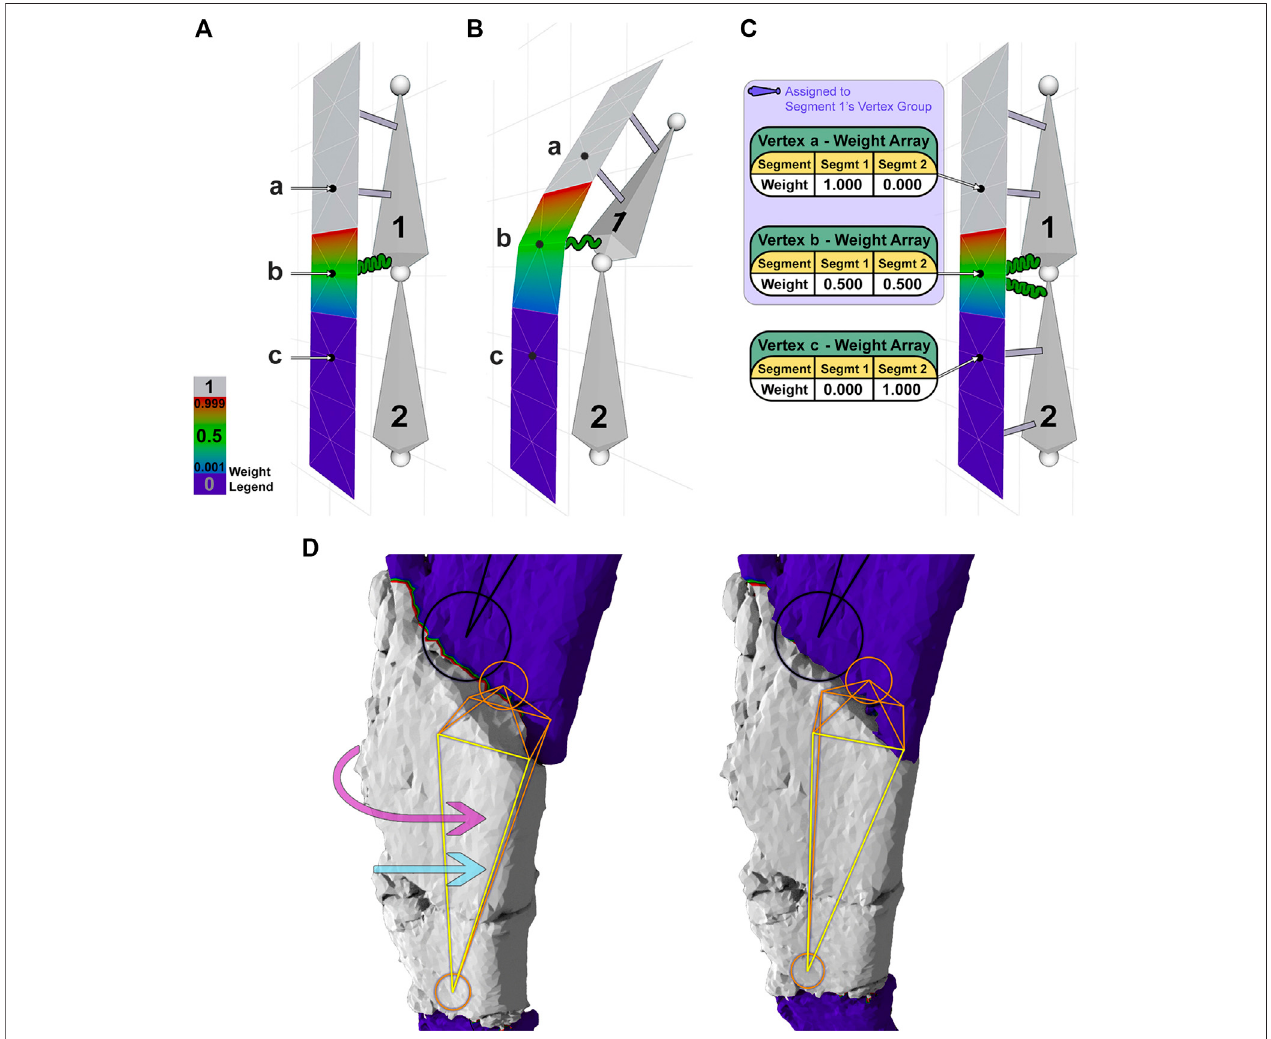
FIGURE 4 | A 2-segment armature is used to demonstrate weight painting and its effect on a mesh (A – C). (A) Segment 1 controls the upper one-half of the mesh. Vertexa(weight1.0)isattached tosegment1byaninelasticgrayconnector,vertexb(weight0.5)isattachedtosegment1withanelasticgreenconnector,andvertexc (weight0.0)hasnoattachmenttosegment1. (B) Movingsegment1displacesverticesa-caccordingtotheirweights. (C) Segments1and2controltheupperandlower portions of the mesh, respectively, with weight arrays shown for each vertex. (D) Reversing a major fracture of the dorsal rib involves rotation (pink arrow) and translation (blue arrow) of the underlying segment (orange/yellow) to move the corresponding fragment (gray) into alignment. Note the rotation of the orange segment (closest face is highlighted yellow) and the occlusion of the shaded area at the proximal end of the fragment.